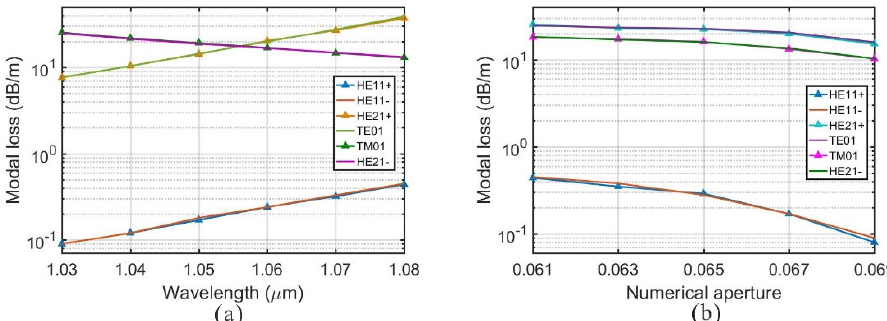
Figure 7. ( a ) Modal losses of a twisted octagon-shaped core fiber versus wavelength with R = 25 μm, Λ = 4.2 mm, and NA = 0.065, λ in the range of 1.03–1.08 μm. ( b ) Modal losses of a twisted octagon- shaped core fiber versus NA with R = 25 μm, Λ = 4.2 mm, and λ = 1064 nm, NA in the range of 0.061–0.069.